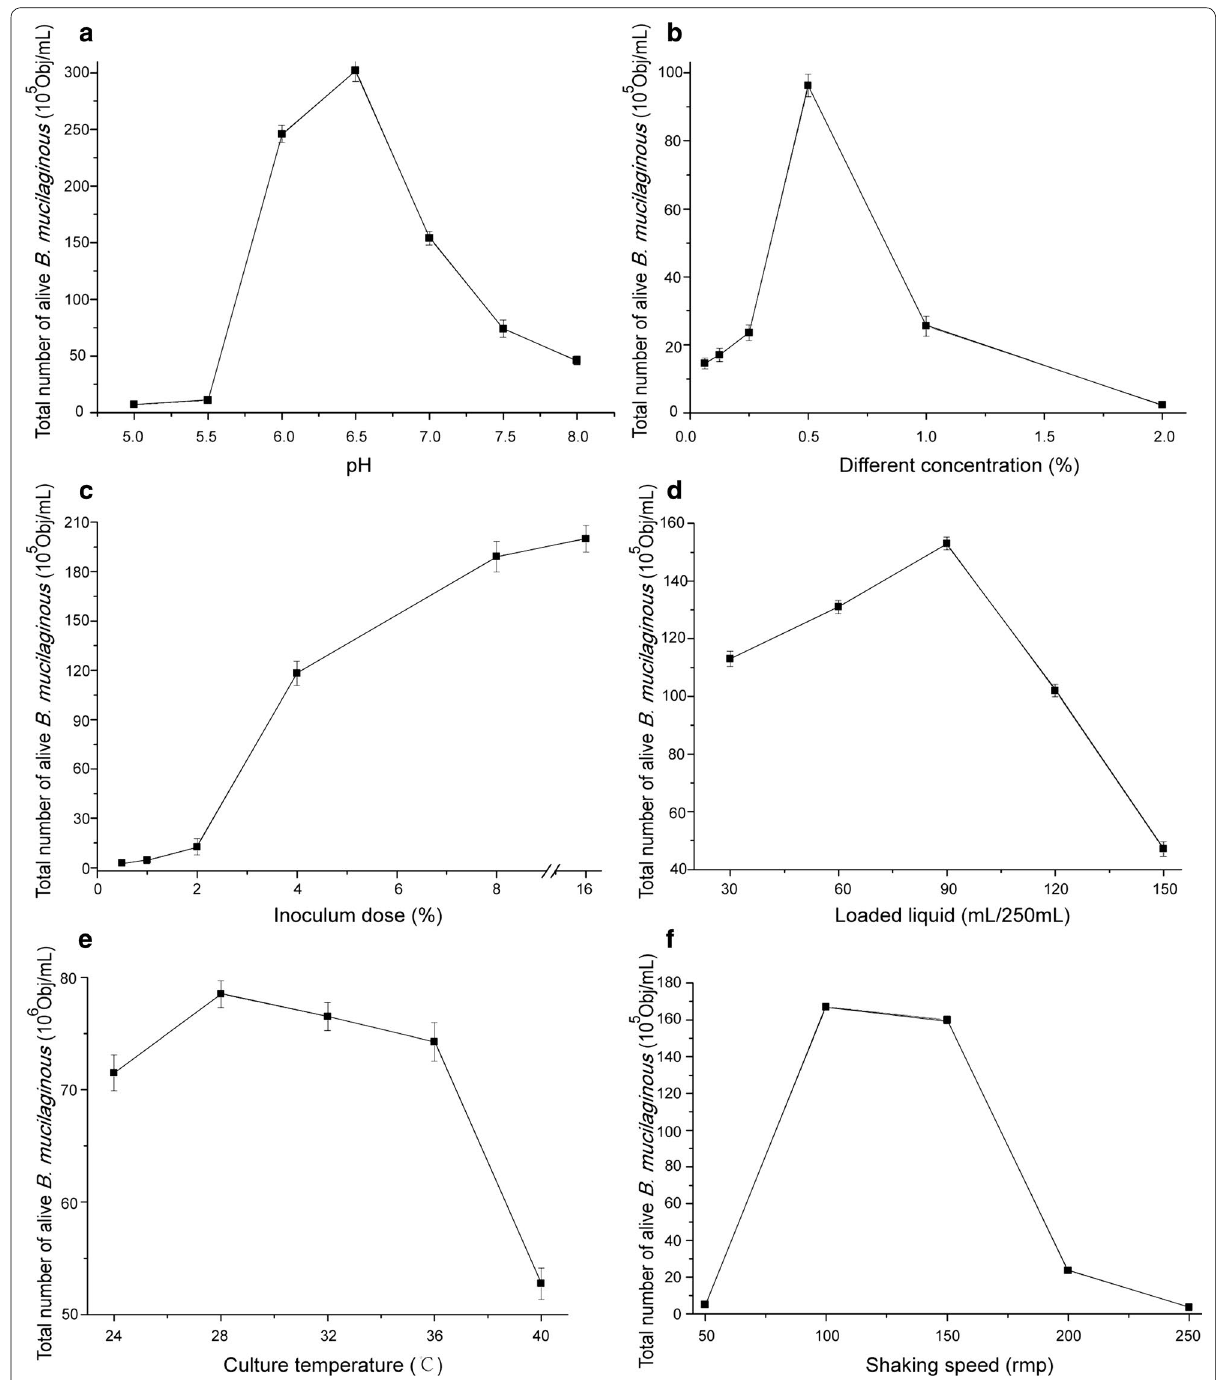
Fig. 3 Results of the single-factor test. Effect of ( a ) initial pH, ( b ) concentration, ( c ) inoculum, ( d ) initial volume of loaded liquid, ( e ) culture temperature, and ( f ) shaking speed on total number of live B.